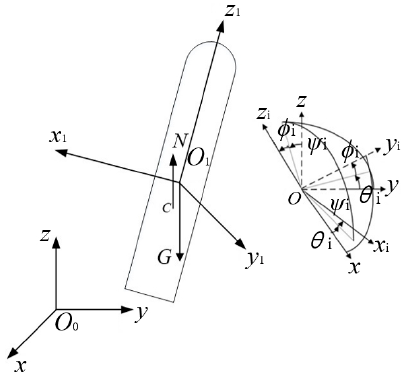
Figure 1. De fi nition of two coordinate systems of the water-exit process. Figure 1. Definition of two coordinate systems of the water-exit